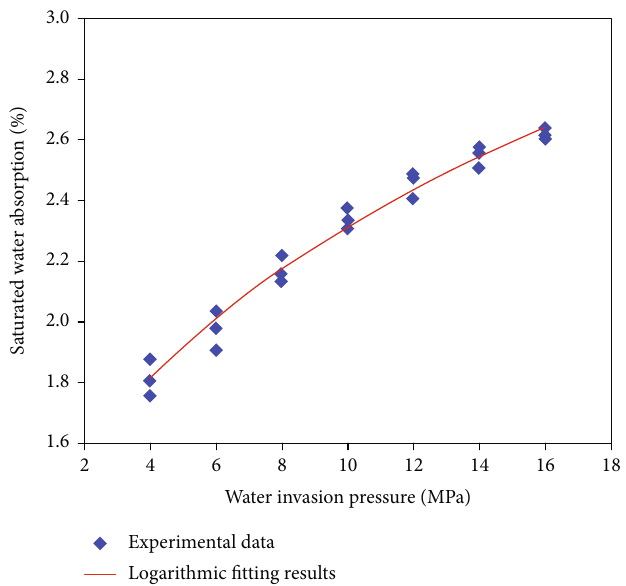
Figure 3: Relation between saturation water absorption and water invasion pressure.